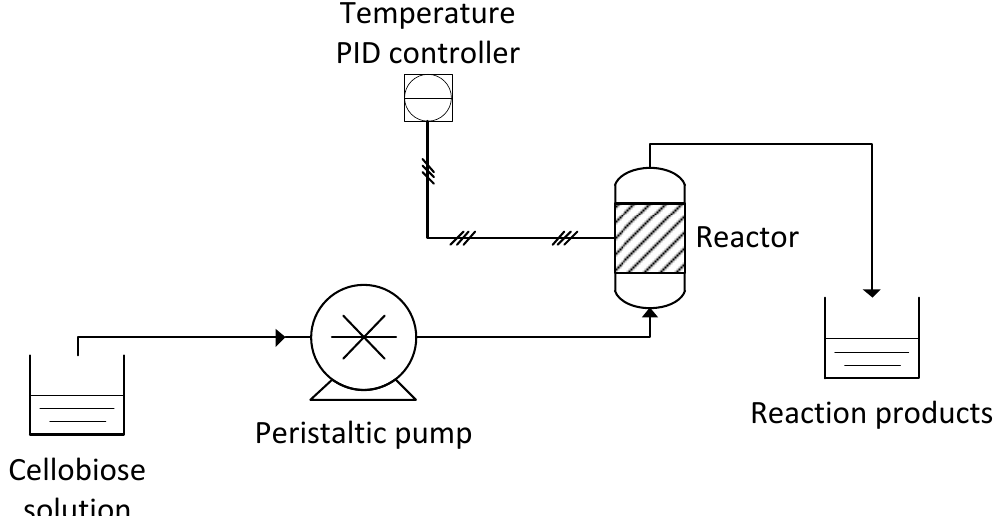
Figure 8. Process flow diagram of the continuous flow test rig.